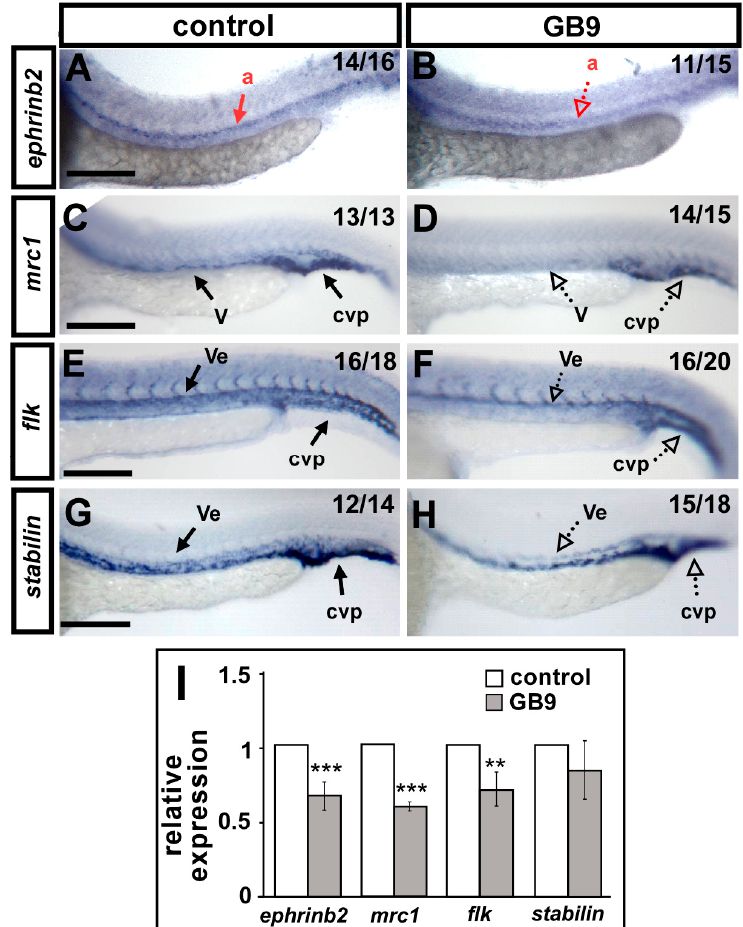
Figure 5. GB9 exposure reduces the expression of vascular markers. ( A – H ) Compared to wild-type controls ( A , C , E , G ), expression of the arterial marker ephrinb2 ( B ), venous markers mrc1 ( D ), pan-vascular marker flk1 ( F ), and stabilin ( H ) were reduced in the trunk dorsal aorta (a), vein (v), vessels (ve), and caudal vein plexus (cvp) at 24 hpf in GB9 treatment embryos. ( I ) Quantification of the relative expression level by qPCR assay showed a ~40% and 30% reduced expression in vascular markers ephrinb2 (0.65 ± 0.13), mrc1 (0.58 ± 0.05), flk (0.7 ± 0.14) and stabilin (0.84 ± 0.2) in GB9 treatment embryos. Values on the top right indicate the number of embryos exhibiting phenotype per total number of embryos analyzed. *** refers to p < 0.0001 and ** refers to p < 0.001 by an unpaired Student’s t -test. Data are represented as means ± SD. Scale bars represent 200 μ m in ( A – H ).